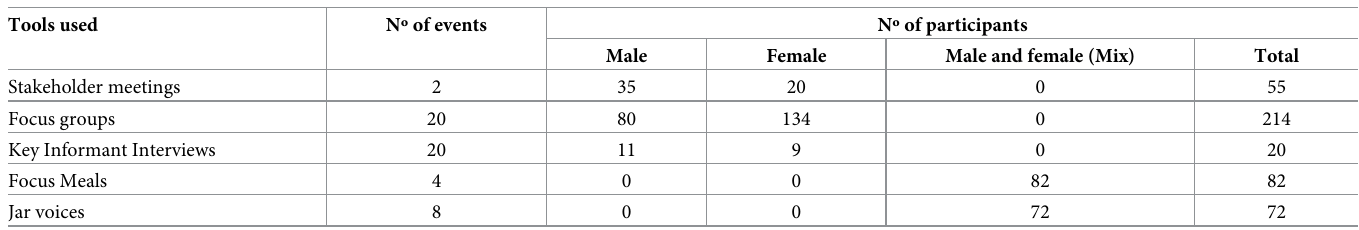
Table 1. Tools used and sample